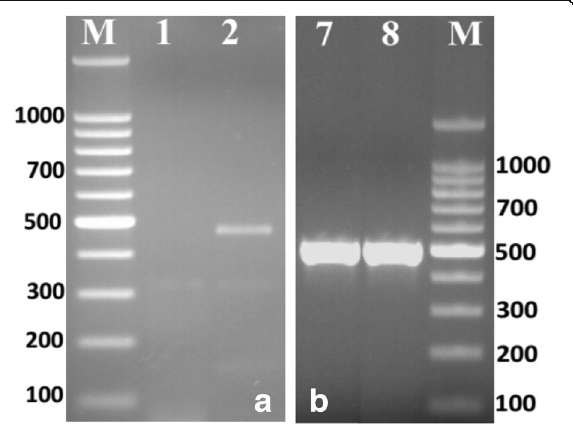
Fig. 5 Validation of the SCAR-2 and SCAR-12 primers against T. koningiopsis -2 ( a ) and T. longibrachiatum- 7 and 8 ( b )